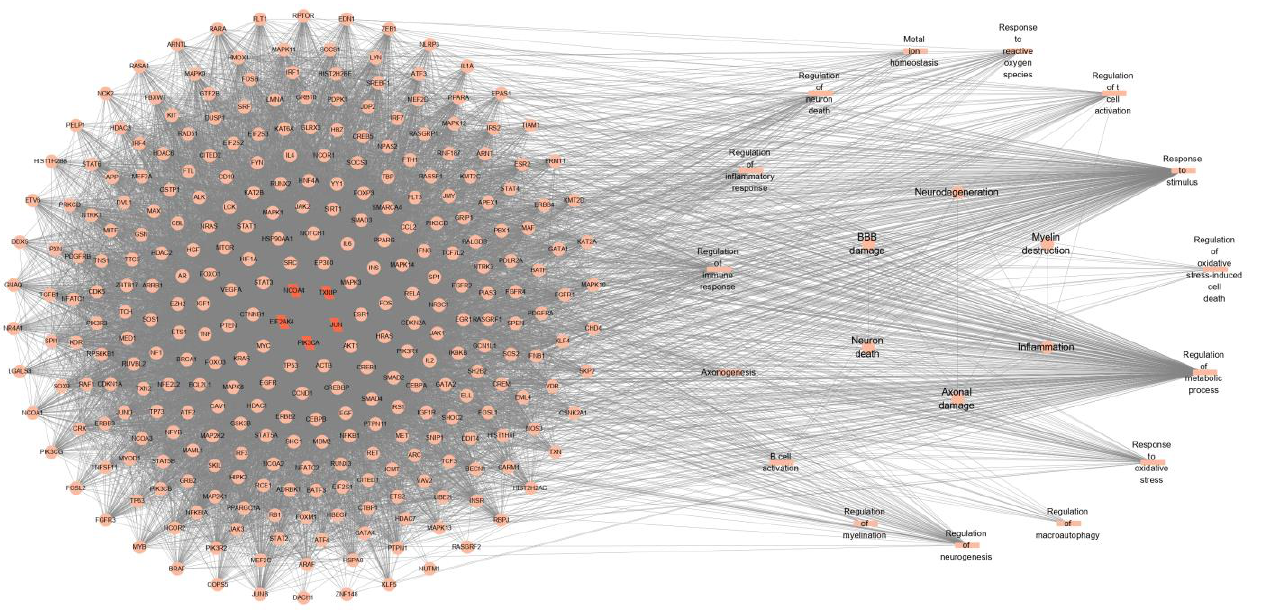
Figure 8. Protein–protein interaction network of 5 hub RRMS-related module genes. The parallelogram indicates the hub FRGs identified by the machine learning algorithm. The circles represent potential targets which interact with hub FRGs in the regulatory network. Biological processes associated with RRMS are represented by rectangles. The nodes in the right-hand circle represent possible induced disease events. Gene–gene interactions are indicated by edges.